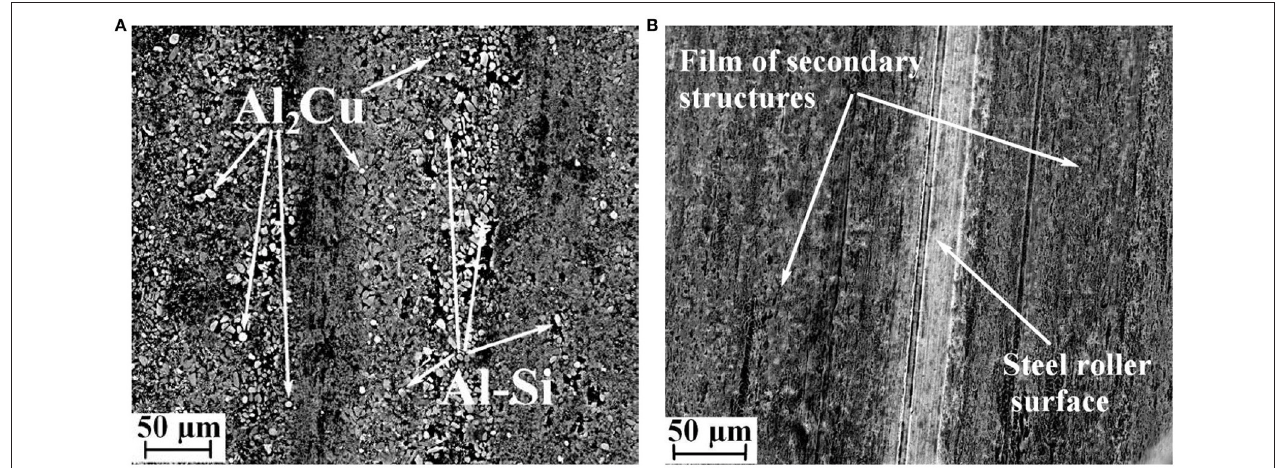
FIGURE 5 | SEM image of the surfaces of the contact pair after testing with lubricant at a pressure of 20 MPa, obtained using a secondary electron detector: (A) shoe (alloy No. 1), (B) roller.